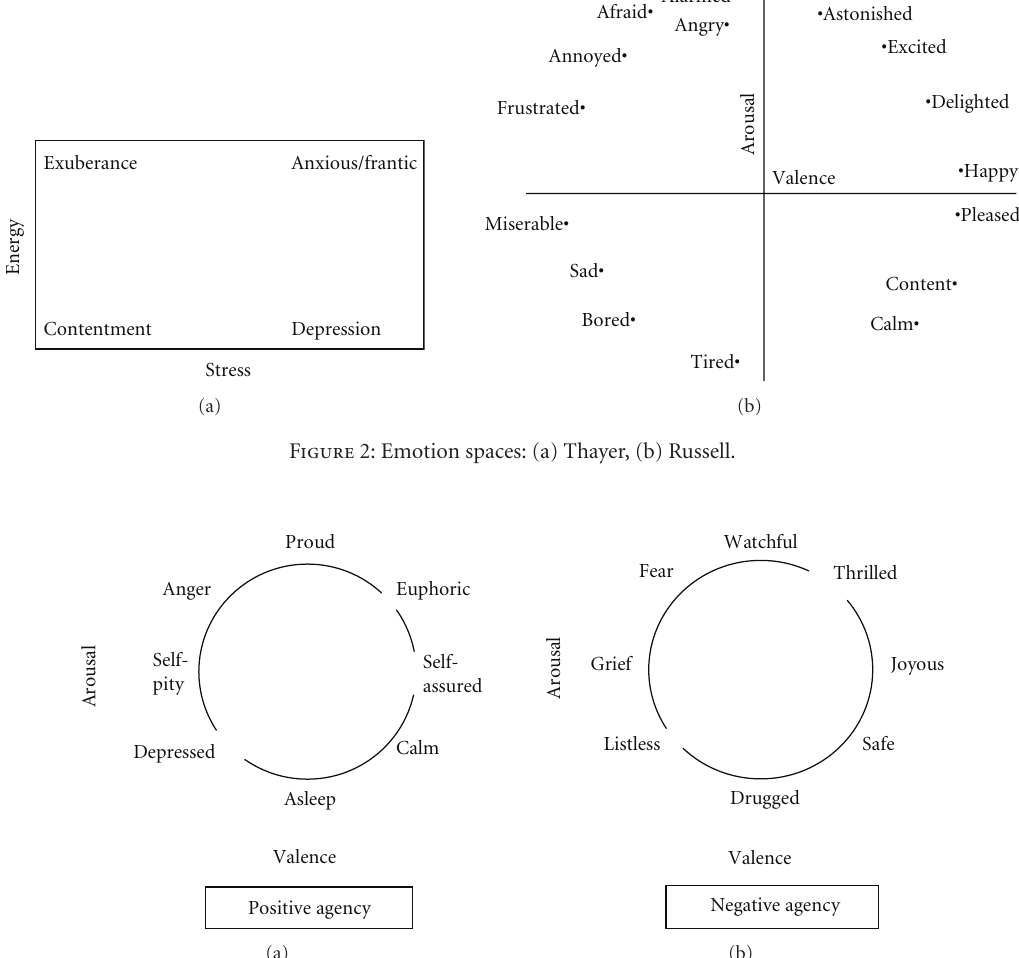
Figure 3: 2D circumplex mapped along the 3rd dimension (agency or stance). Positive agency (a) creates self-oriented emotions like anger, but negative values for agency (b) will result in other-oriented emotions like fear with similar Arousal and